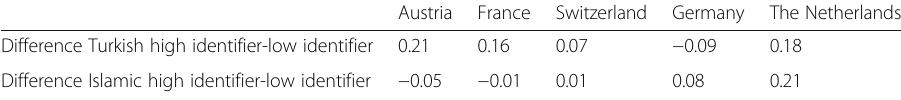
Table 3 Differences in the predicted probabilities between the highest identifiers and lowest identifiers, according to